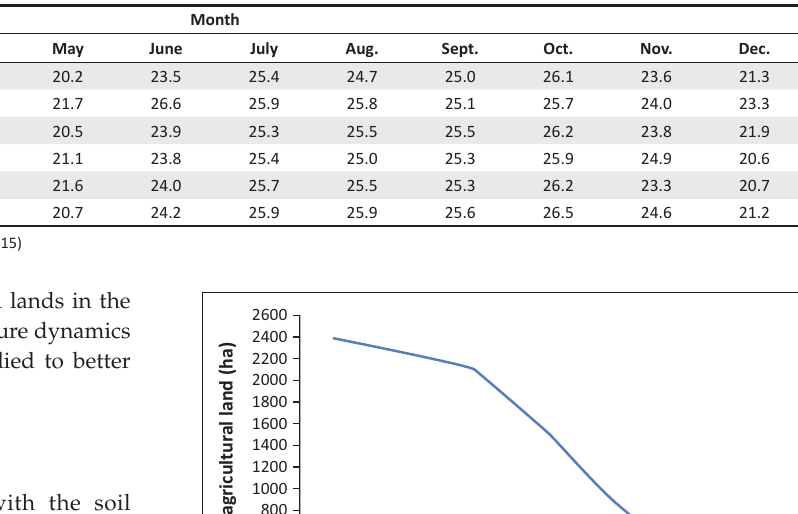
TABLE 2: Monthly means of minimum temperatures (°C).